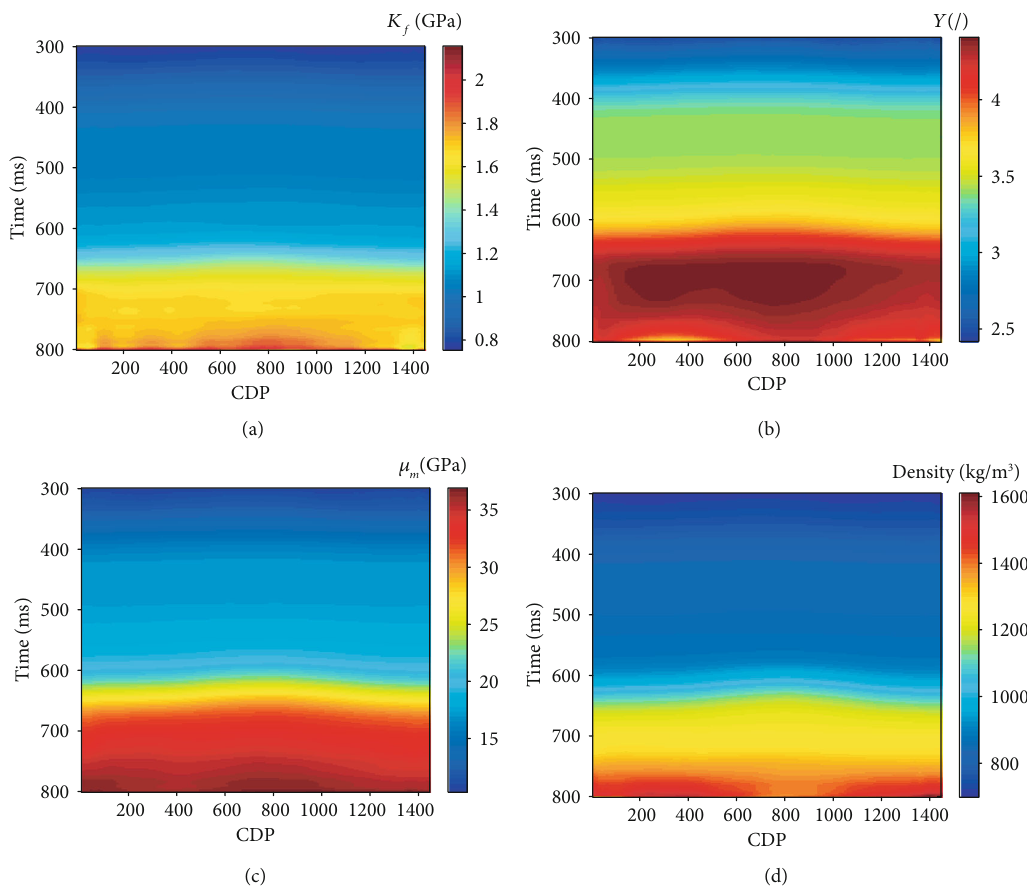
Y , (c) μ Figure 12: The initial model of (a) K f , (b) m , and (d) density from the initial model of P-wave velocity, S-wave velocity, and density shown in Figure 11 in terms of the rock-physical